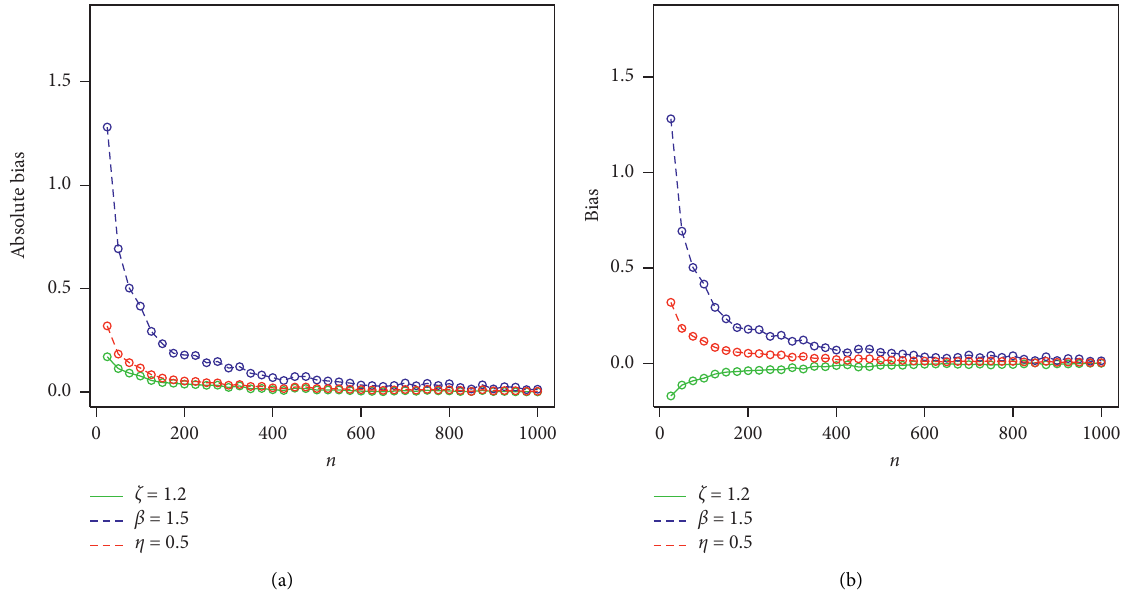
Figure 9: Graphical display of the simulation results provided in Table 2. (a) Plot of absolute biases vs. n. (b) Plot of biases vs. n